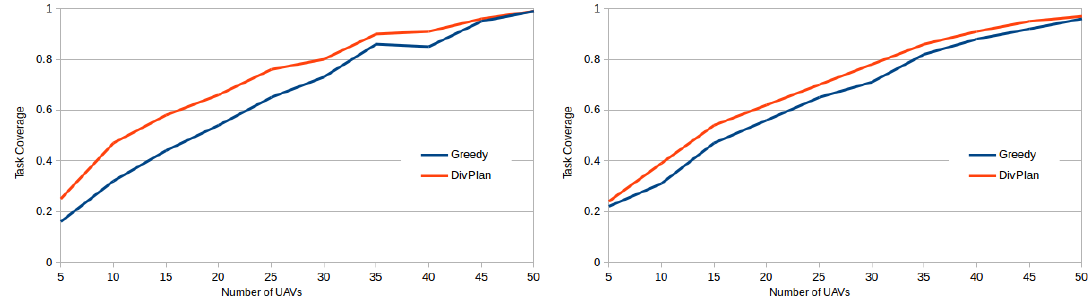
Figure 8. Task coverages for different numbers of UAVs with 3 (left) and 5 (right) sensor